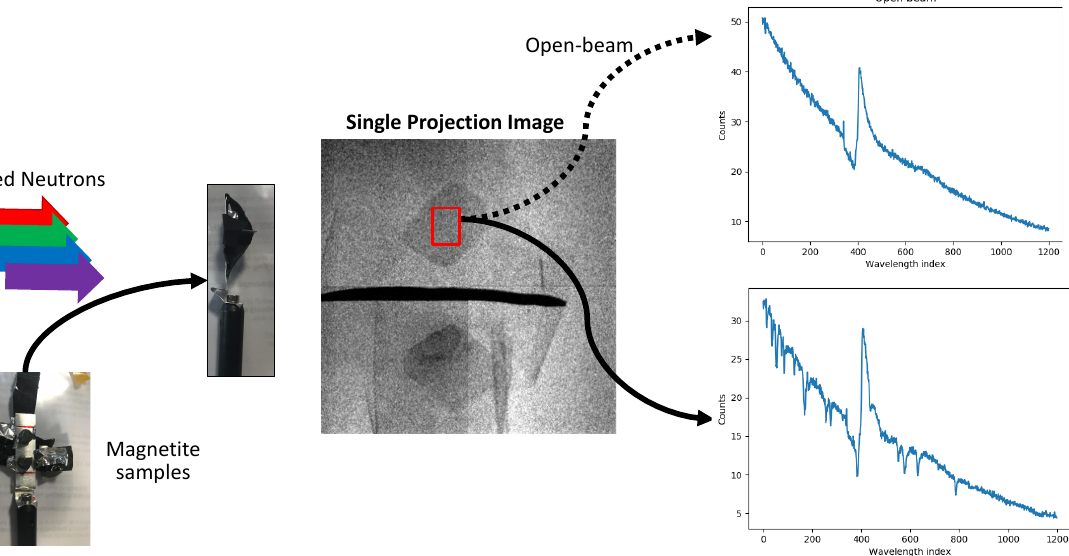
Figure 3. Illustration of the experimental set-up. Two magnetite crystals are mounted on a holder, separated by a piece of cadmium and held by a tape. Each projection image consisted of measurements using a 512 × 512 micro-channel plate detector which natively binned the images into energy-bins. Each such projection measurement took approximately 1.5 h of experiment time and the counts per bin in a region of the sample were approximately in the range of 0 to 35 counts as shown in the plot above (average signal strength in a region indicated by the red